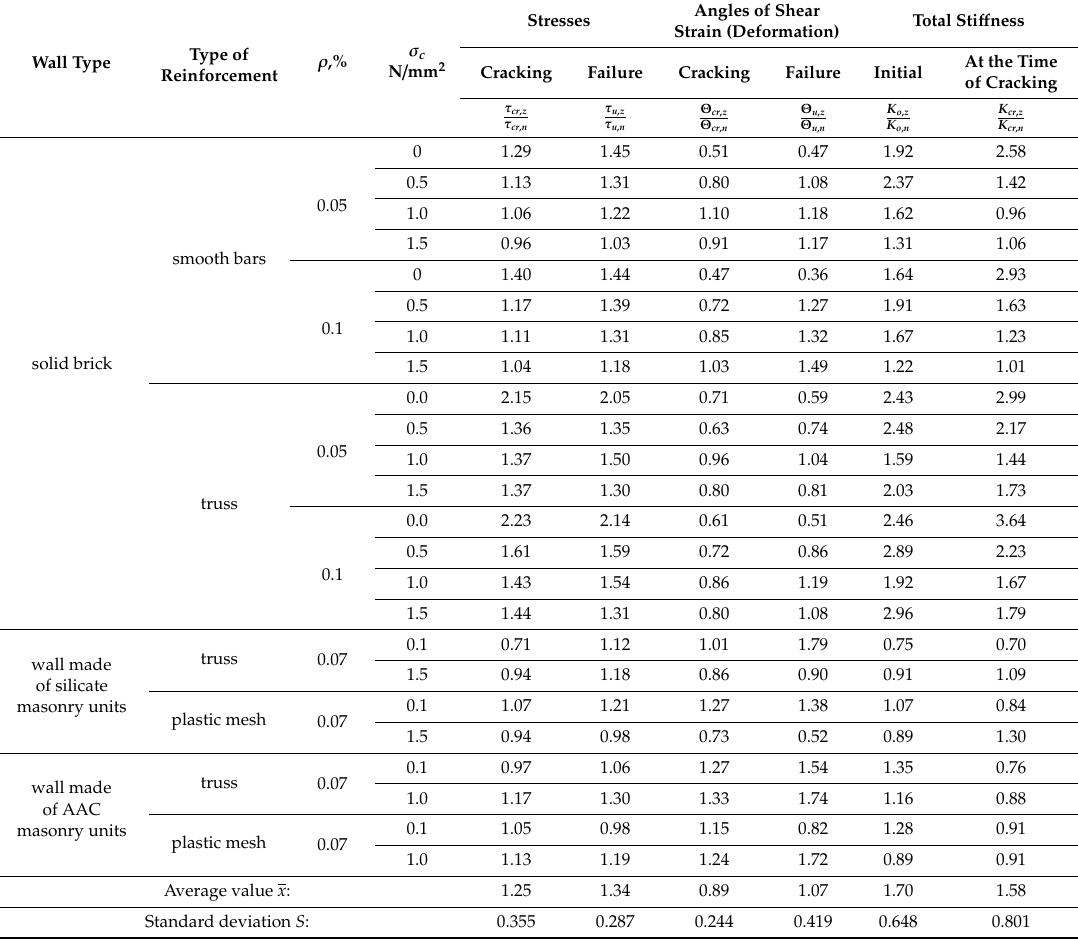
Table 7. Comparison of test results for reinforced walls of all tested series of